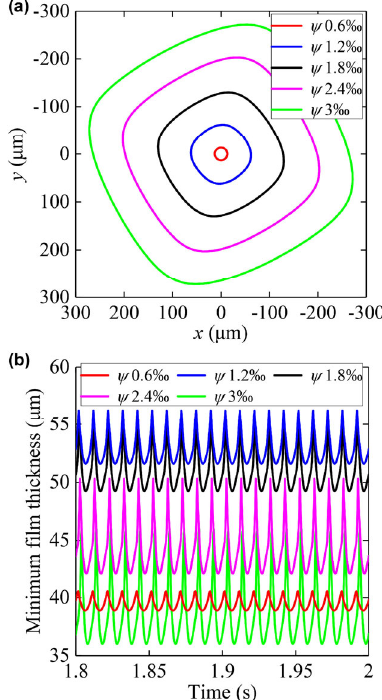
Fig. 11 (a) Journal center orbits and (b) dynamic minimum film thicknesses of a TPJB without static loads for different clearance ratios.